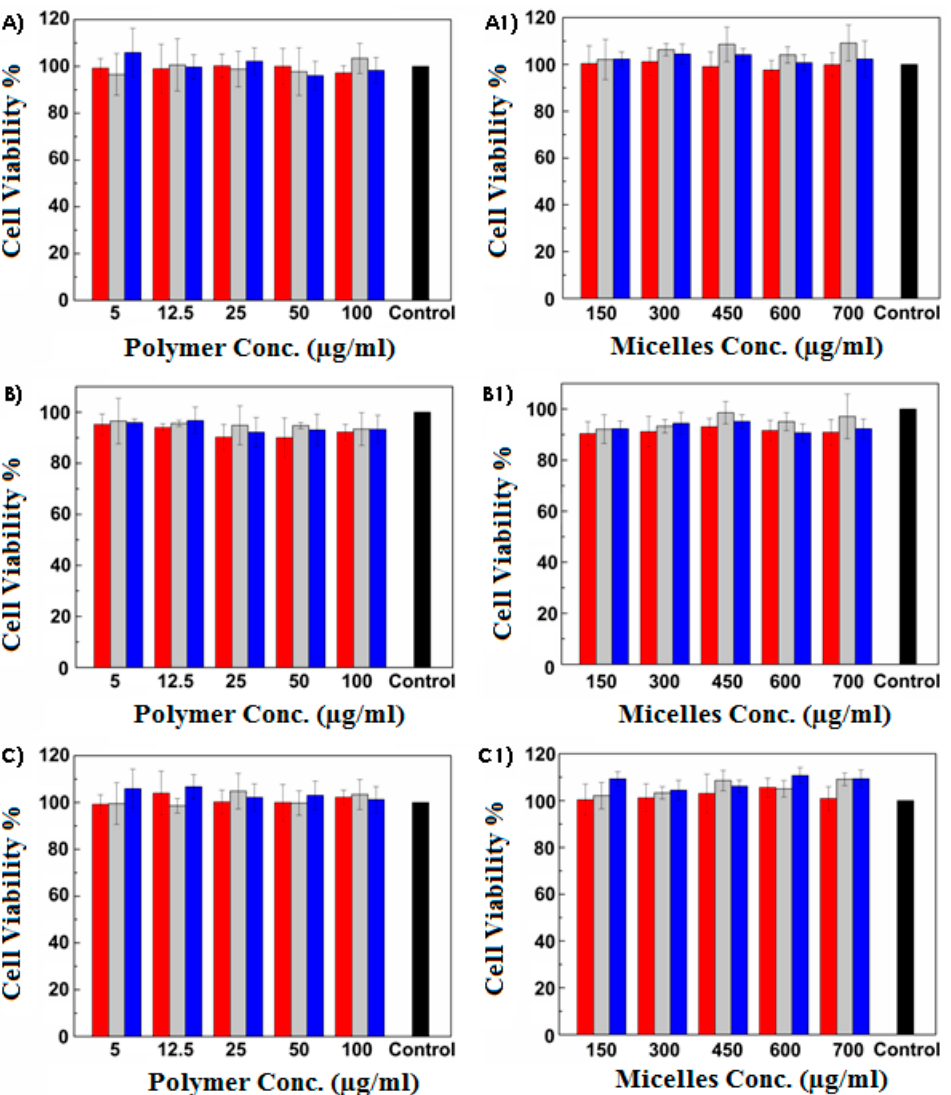
Figure 2. Cytocompatibility studies against HCE cells: Cell viability percentage with reference to untreated cells used as a control (black) after incubation for 1 h (red), 4 h (grey), and 24 h (blue) with INU-EDA-TAU-RA ( A ) solutions and ( A1 ) micellar dispersions; INU-EDA- RA-CAR ( B ) solutions and ( B1 ) micellar dispersions and INU-EDA-RA-CRE ( C ) solutions and ( C1 ) micellar dispersions. The calculated cell viability values at different concentration and different time points did not result in statistically significantly differences ( p > 0.05).